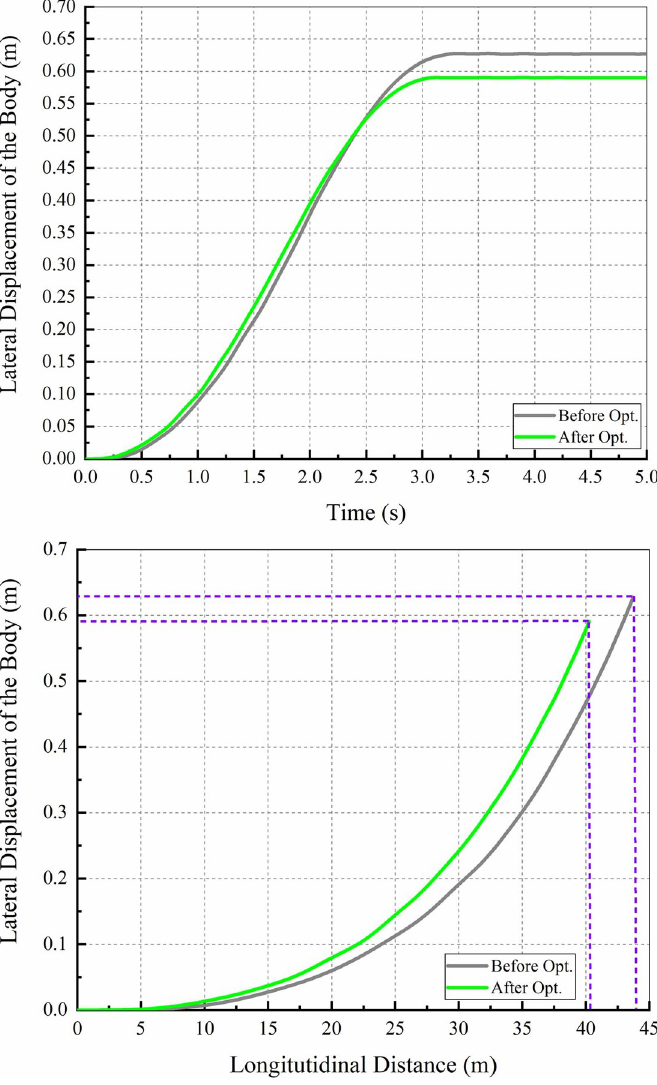
Table 11. Comparison of the indicators.